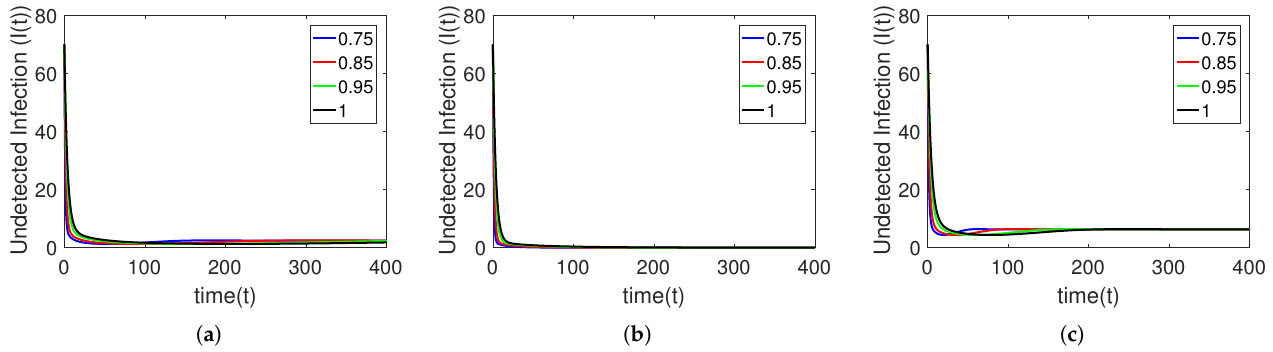
Figure 14. Graphical view ( a – c ) of Undetected infected class on different arbitrary orders γ = 0.75, 0.85, 0.95, 1 for initial data and time duration for TB model by taking the value of β = 0.75, 0.075, 1.75.